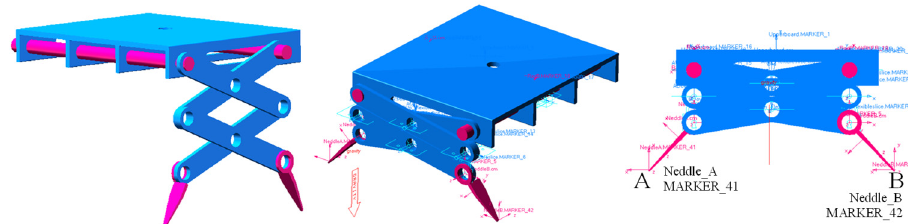
Figure 11. Simulation in ADAMS.